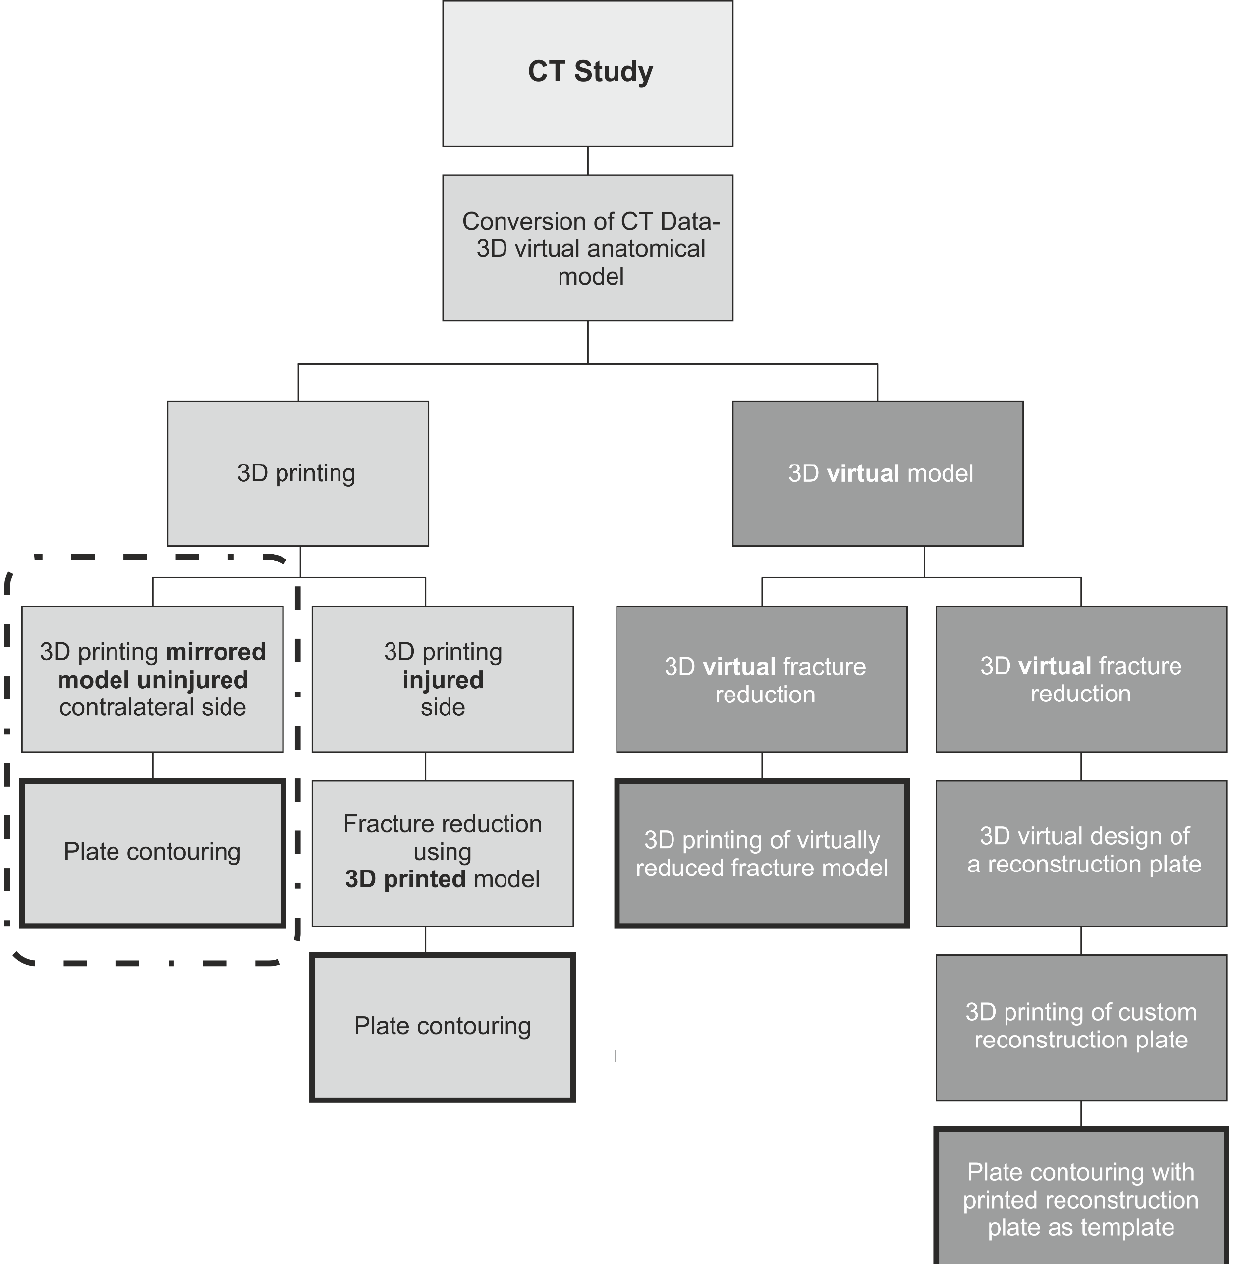
Figure 1. Diagram showing current approaches to preparing and using 3D printed models as templates for pre-contouring fixation plates.